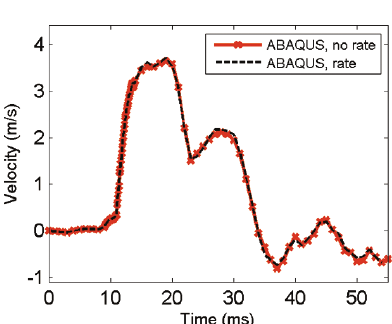
Fig. 19. Comparison with experimental velocity data, dynamic shear test.